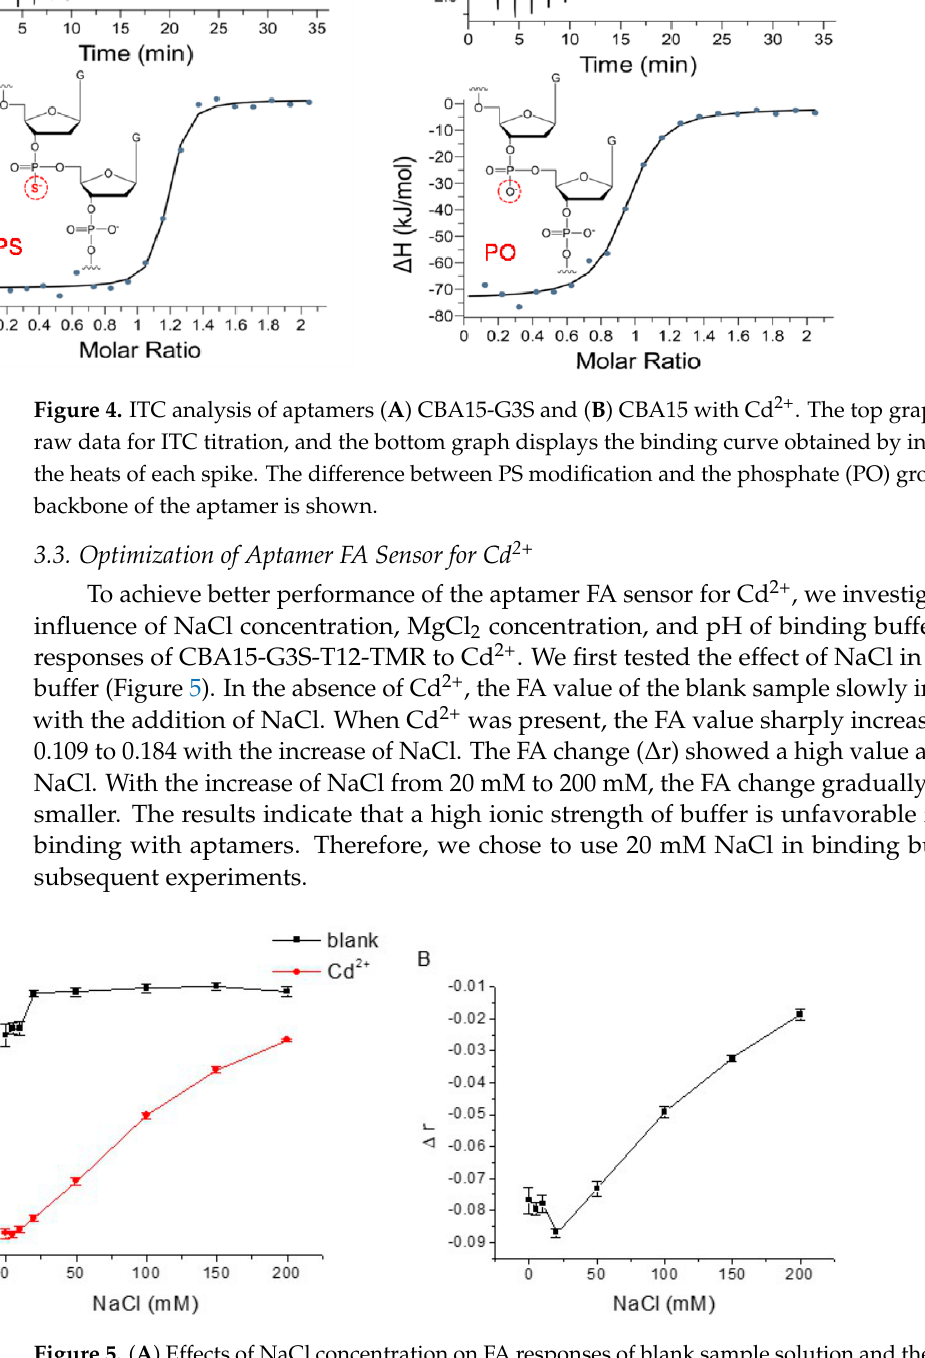
Figure 5. ( A ) Effects of NaCl concentration on FA responses of blank sample solution and the solution containing 1000 nM Cd 2+ with 20 nM CBA15-G3S-T12-TMR. ( B ) The relationship between FA changes ( Δ r) caused by Cd 2+ and NaCl concentration.